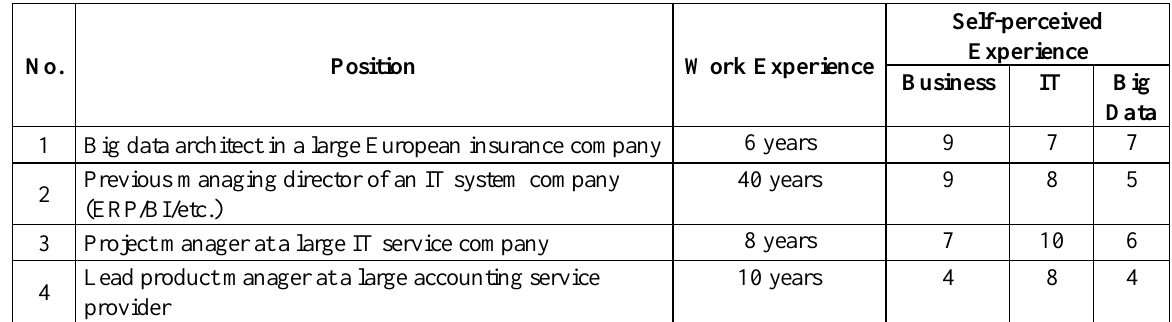
Table 2. Information about the interviewed experts. The given self-perceived experience ranges from low (1) to high (10).